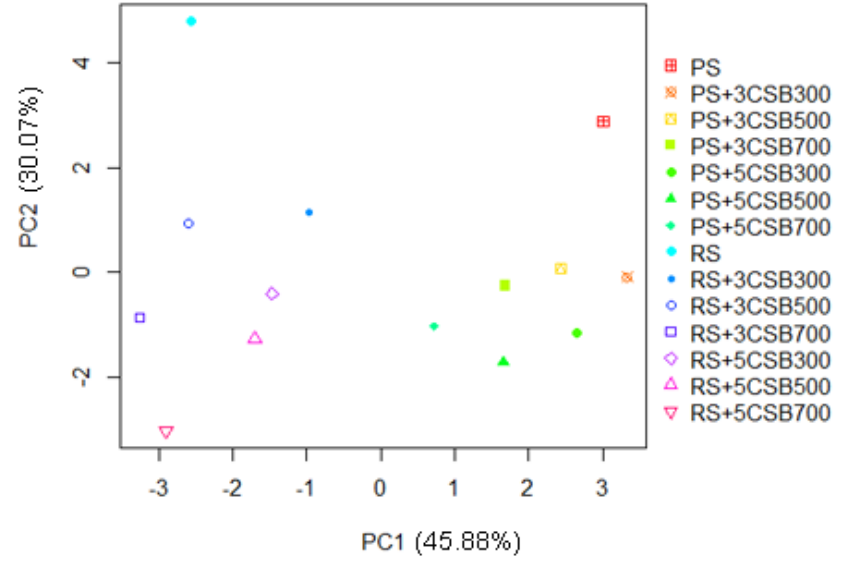
Figure 4. Score plot of the principal component analysis (PCA).